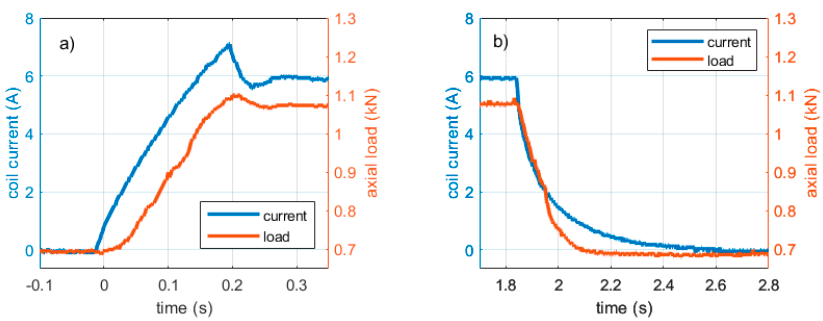
Figure 11. Axial force increments due to the change in current intensity (0–6 A): ( a ) current increased from 0 to 6 A; ( b ) current reduced from 6 to 0 A.